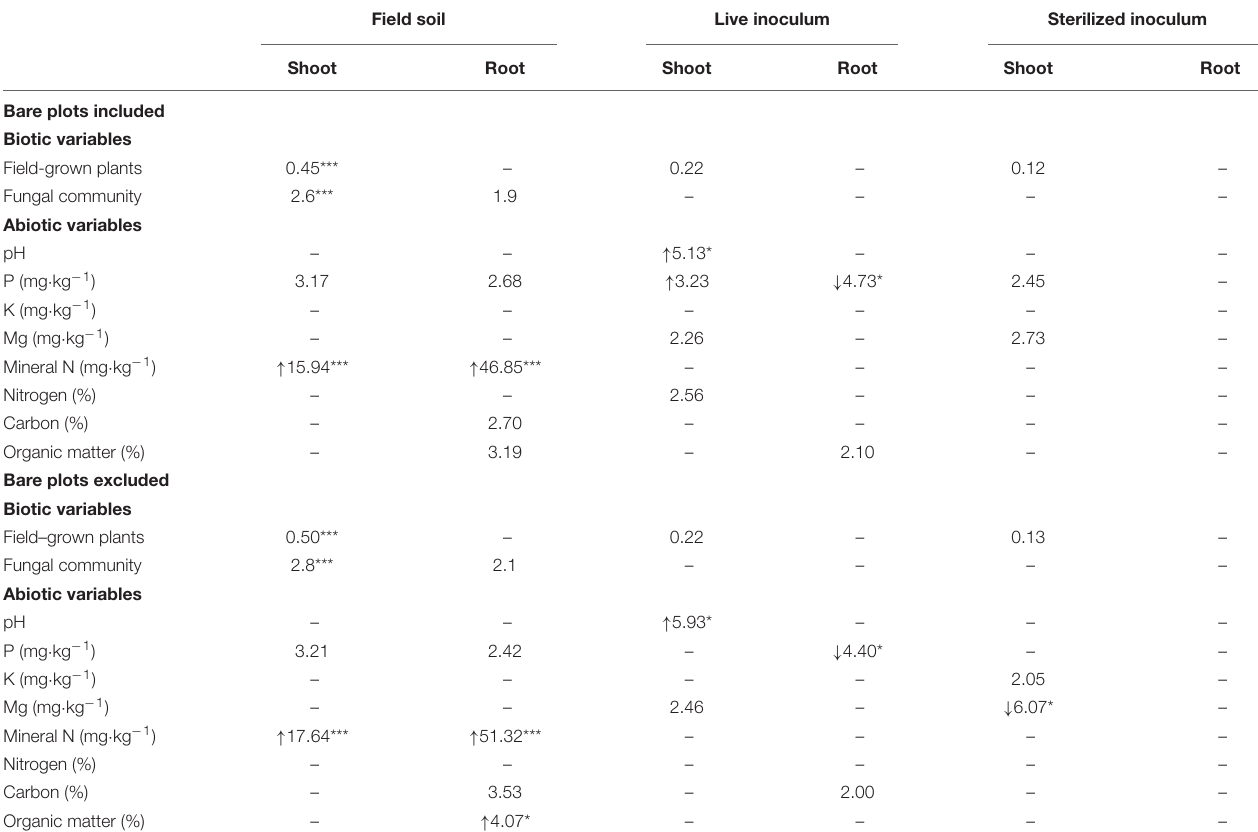
TABLE 2 | Relationship between the performance of plants (root and shoot biomass) from the three soil treatments (field soil; live inoculum; sterilized inoculum), and performance of plants grown in the field experiment, fungal community composition, and soil nutrient